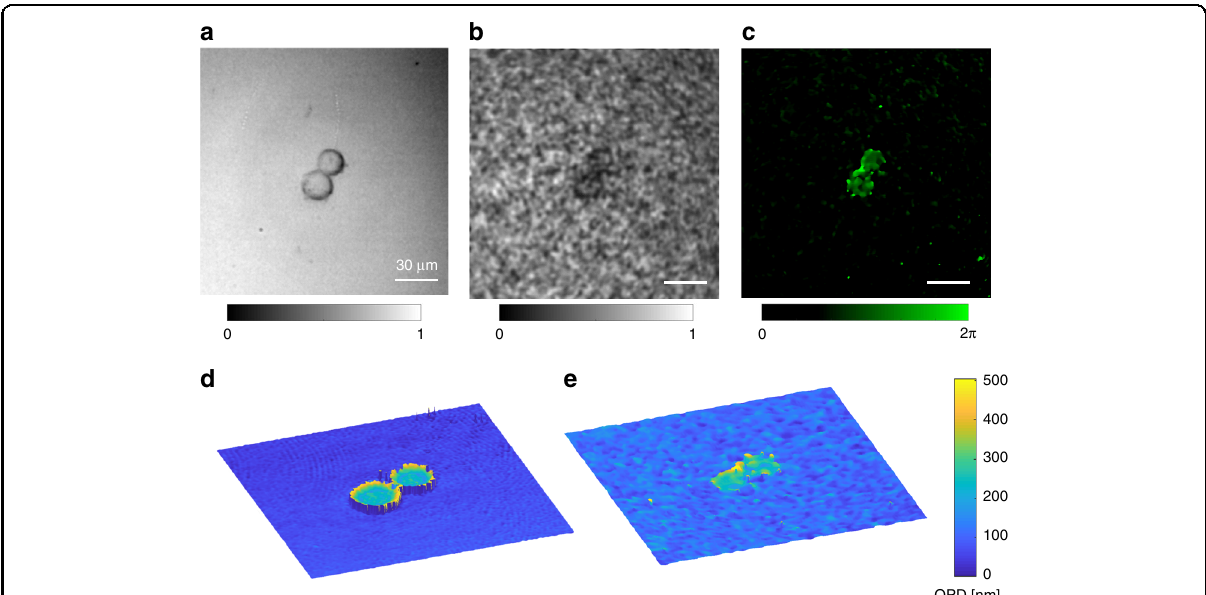
Fig. 6 Quantitative phase imaging of cancer cell cytokinesis via microendoscope. a Intensity image of a HeLa cell in cytokinesis from a conventional re fl ective microscope. b , c Microendoscopic b amplitude and c phase reconstruction of the HeLa cell in cytokinesis from the far- fi eld speckle. Scale bars 30 μ m. d , e 3D OPD map of the HeLa cell measured from the d conventional digital holographic microscope and the e quantitative phase